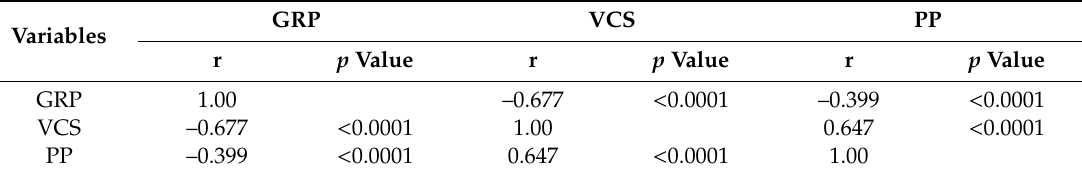
Table 3. Partial correlation analysis between GRP, vascular calcification score (VCS) and pulse pressure (PP) after adjustments for age and gender.